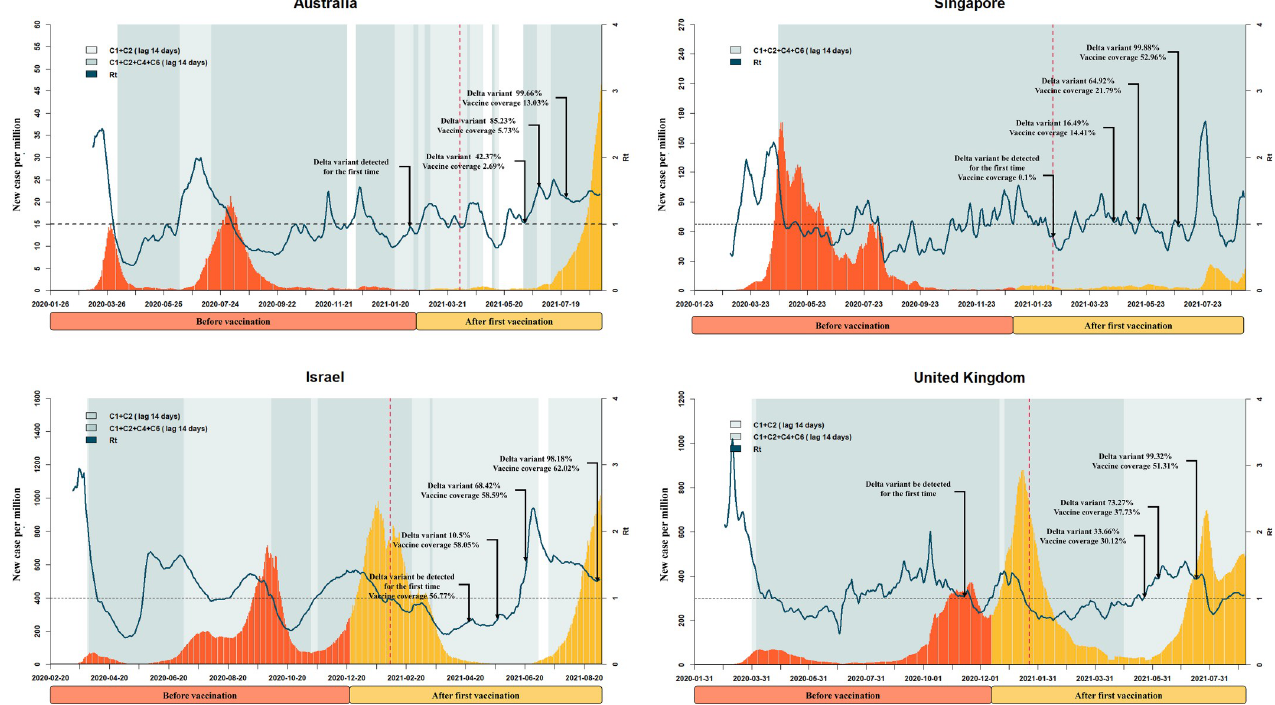
Fig 1. Key events during the progression of the pandemic in the Australia, Singapore, Singapore and United Kingdom. The x axis represents time. The y axis represents daily new confirmed cases. The fluctuation line represents the effective reproductive number (R t ). The shading represents the implementation of a public health measure plus 14 days (lag time). The light-to-dark color shift indicates a gradual increase of stringency. The dotted vertical line represents the announcement of vaccination plus 40 days (lag time). Some key proportions of Delta variant and vaccine coverage are marked using dark arrows.